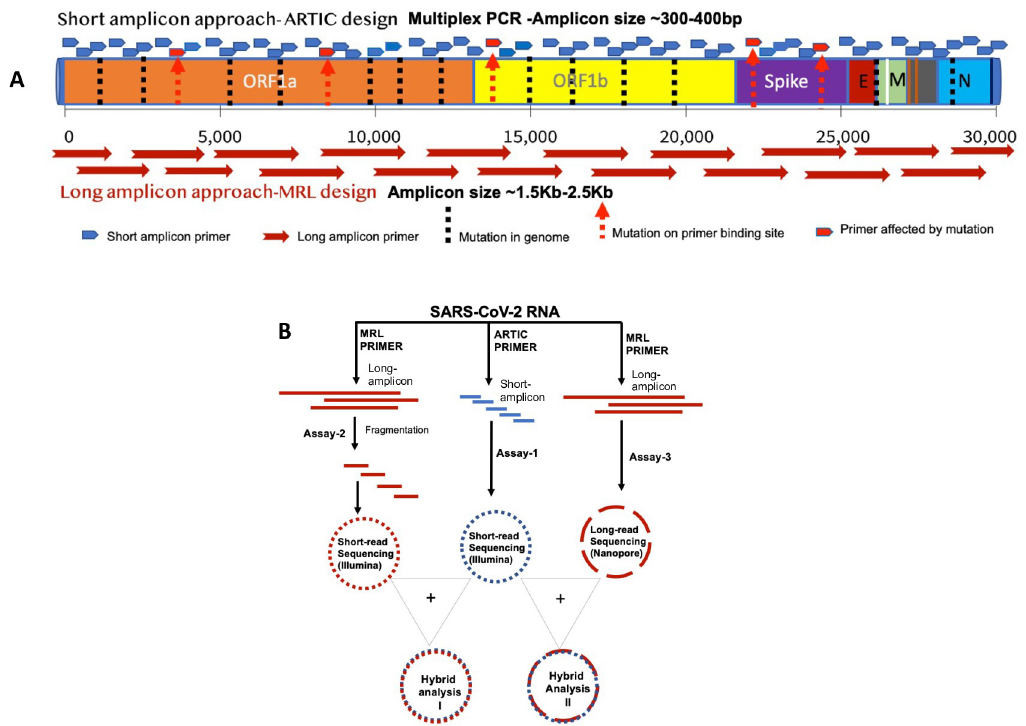
Fig 1. Study rationale and assay design. Panel A illustrates the study’s rationale and sketches the layout of the ARTIC and MRL primer pools across the SARS-CoV-2 genome. Small and long arrows indicate short and long amplicons, respectively. Red arrows indicate a mutation with potential to alter the primer binding site. Panel B shows the design of the three assays developed and assessed in the present study. Assay-1 is based on short-amplicons generated with the ARTIC primer pool. Assay-2 is based on long-amplicons made with MRL primers followed by short-read sequencing on MiSeqDx. Assay-3 is based on long- amplicons sequenced by long read sequencing technology on MinION platform.